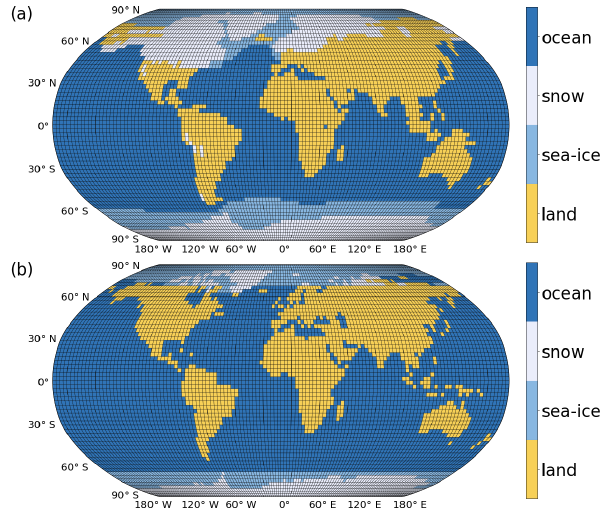
Figure A1. Configuration of land, sea, and ice during (a) the LGM and (b) the mid–Holocene warm period about 6000BP as they were used for the sensitivity test discussed in Sect. 3.2. Panel (a) is from Zhuang et al. (2017a); panel (b) has a land–sea distribution based on the sea level reconstruction from Grant et al. (2012) and the to- pography by the National Geophysical Data Center (1993). Ice was interpolated according to sea level difference of this state to (a) and the modern map from Fig.